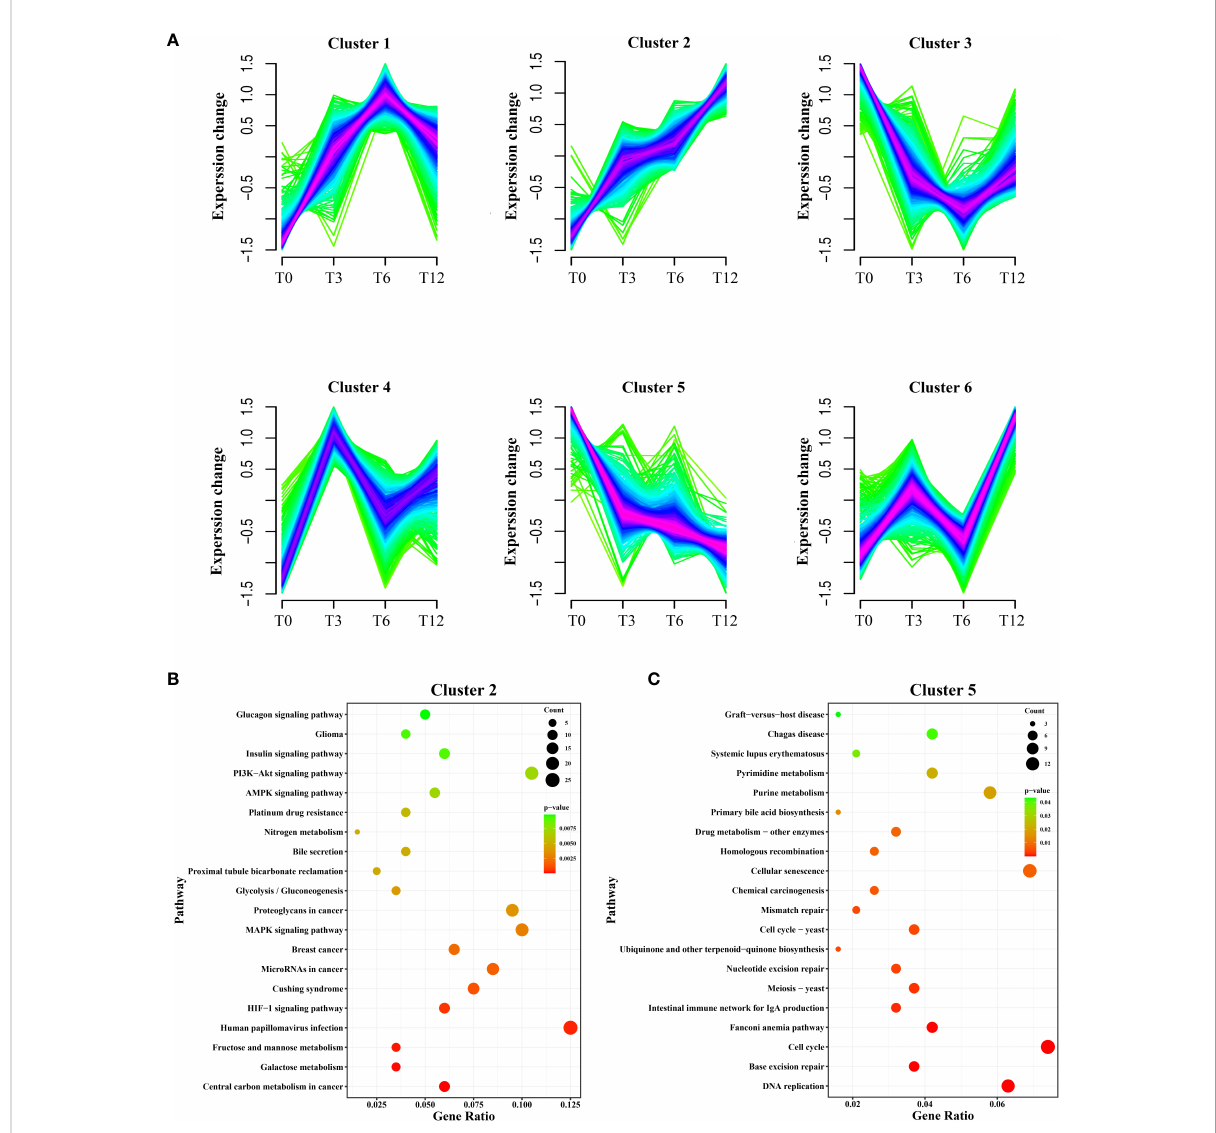
FIGURE 3 Soft clustering pro fi les of DEGs after hypoxia. (A) The dynamic expression patterns of the DEGs were analyzed by Mfuzz R package. Six clusters (cluster 1-6) were identi fi ed based on the similarity in expression patterns. Different colors indicate the match degrees between changes of genes and the major changes of the clusters. Fuchsia, blue and green represent high, moderate and low match degrees, respectively. (B) KEGG enrichment analysis of DEGs in cluster 2. (C) KEGG enrichment analysis of DEGs in cluster